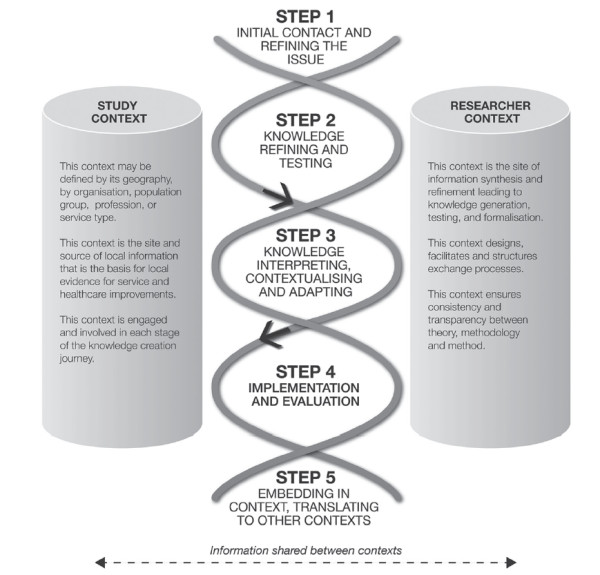
The co-KT Framework.